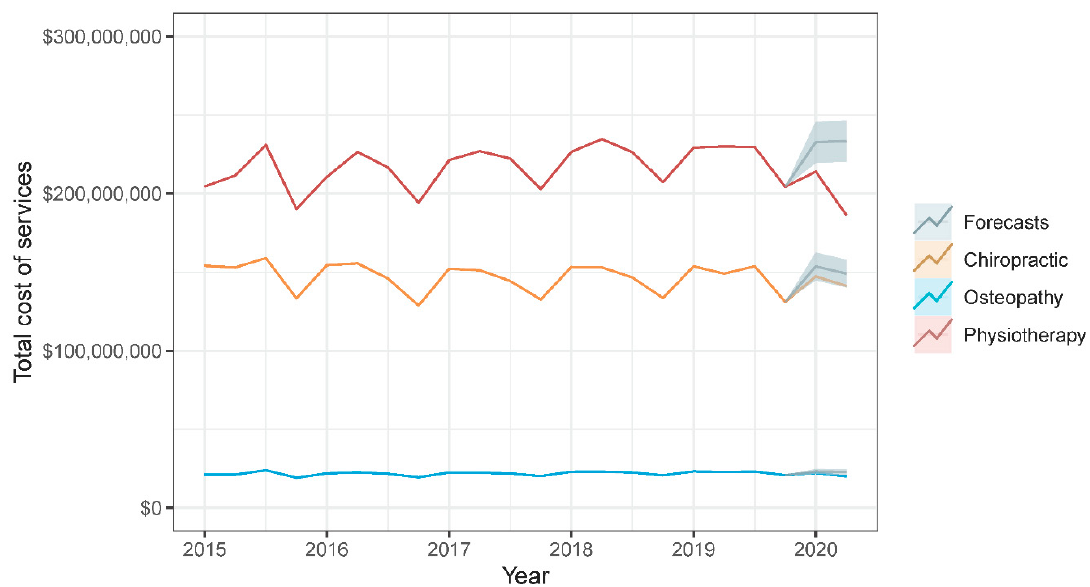
Figure 2. Time series plot of observed values and point forecast estimates with 95% prediction intervals of the quarterly total cost of services provided by each manual therapy profession from 2015 to 2020 Q2. Table 1. Observed values, forecast point estimates, mean errors, and mean percentage errors of the quarterly number and total cost of services provided by each manual therapy profession in Australia during 2020 Q1 and Q2.